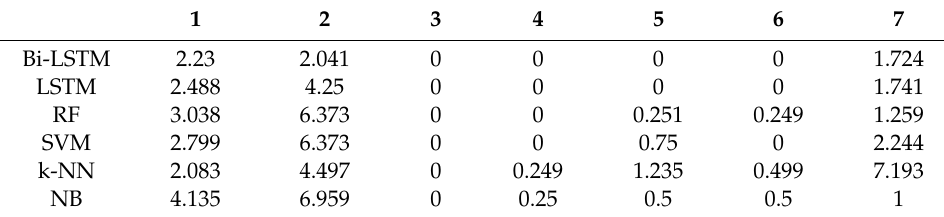
Table 3. Representation of commission errors for every class.